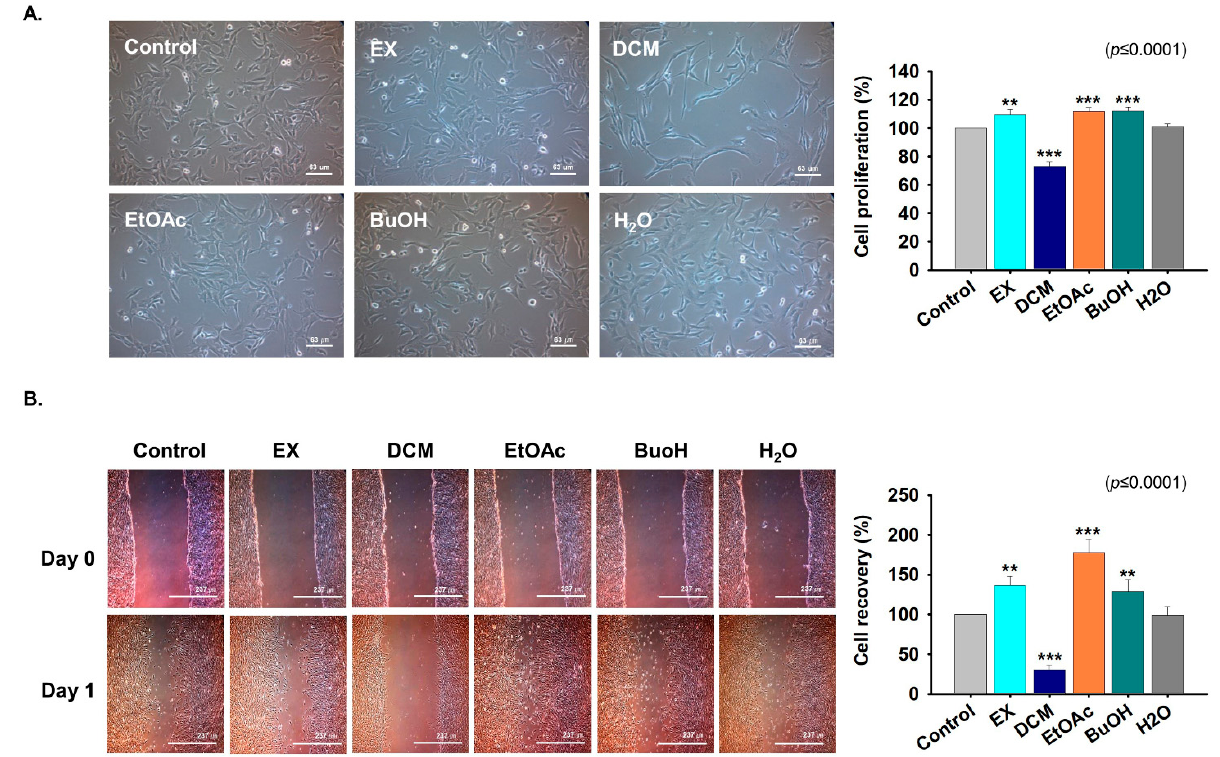
Figure 3. Cell proliferation in the presence of the five fractions of the CWE of G. uralensis . ( A ) C2C12 cells were cultured in growth media supplemented with the five different fractions (25 µ g/mL) of G. uralensis CWE for one day. Cell proliferations after treatment with the EX, DCM, EtOAc, BuOH, or H 2 O fractions as determined by MTT assay. ( B ) When the cells were reached at 100% confluency, scratch was performed after incubation with each fraction for one day. Cell recoveries with the different G. uralensis versus non-treated cells. Means ± SD ( n = 10). ** p ≤ 0.001, *** p ≤ 0.0001.